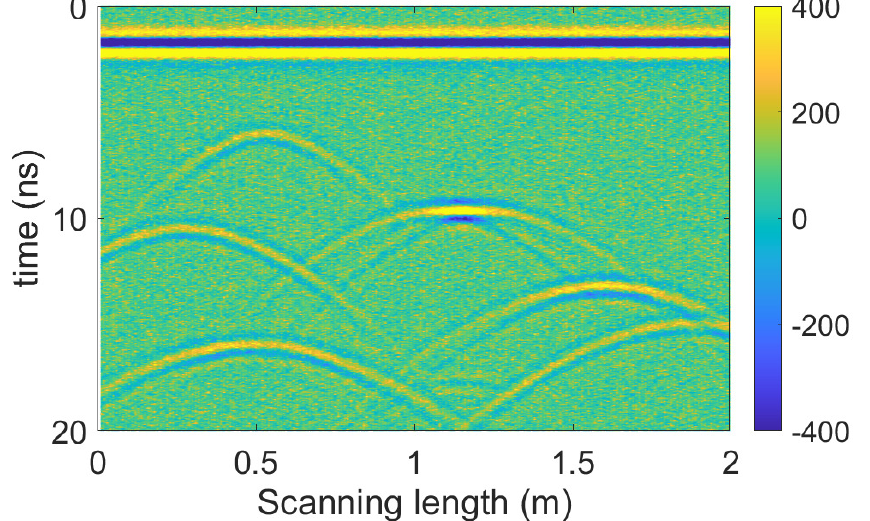
Figure 7. Polluted radargram of the model in Figure